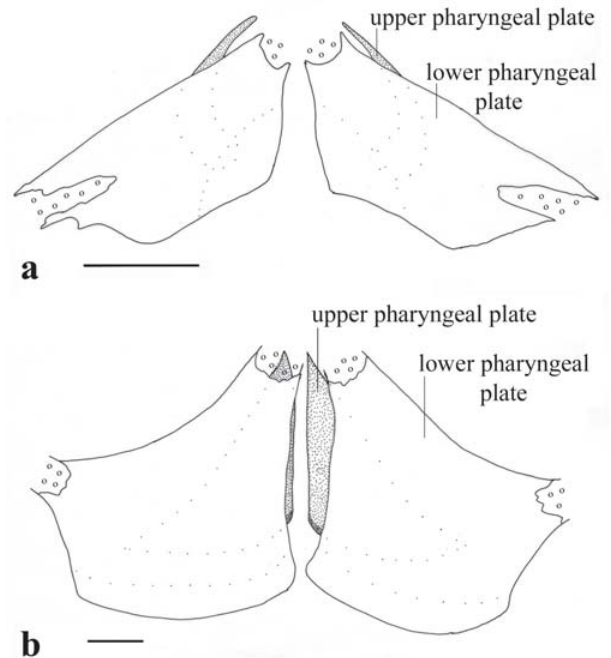
Fig. 24. Ventral view of the lower pharyngeal plate of Harttia loricariformis (MZUSP 66187, 67.7 mm SL) (a) and Sturisoma sp. (MZUSP 50112, 115.2 mm SL) (b). Scale bar = 1